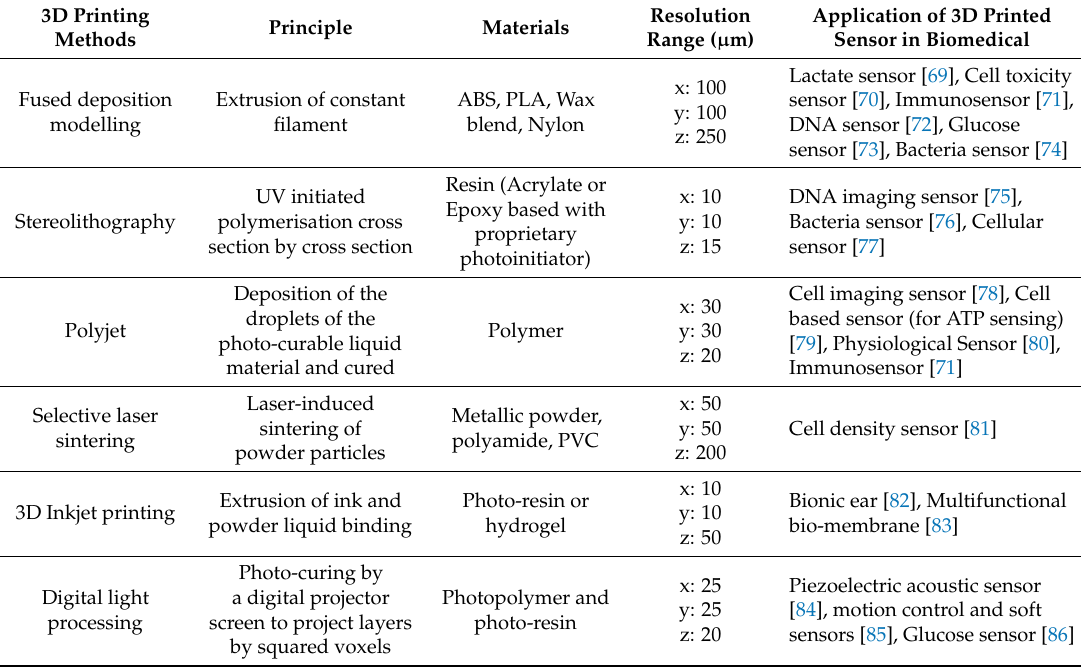
Table 1. A summary of additive manufacturing techniques: principle, materials, resolution and 3D printed sensors in biomedical applications.